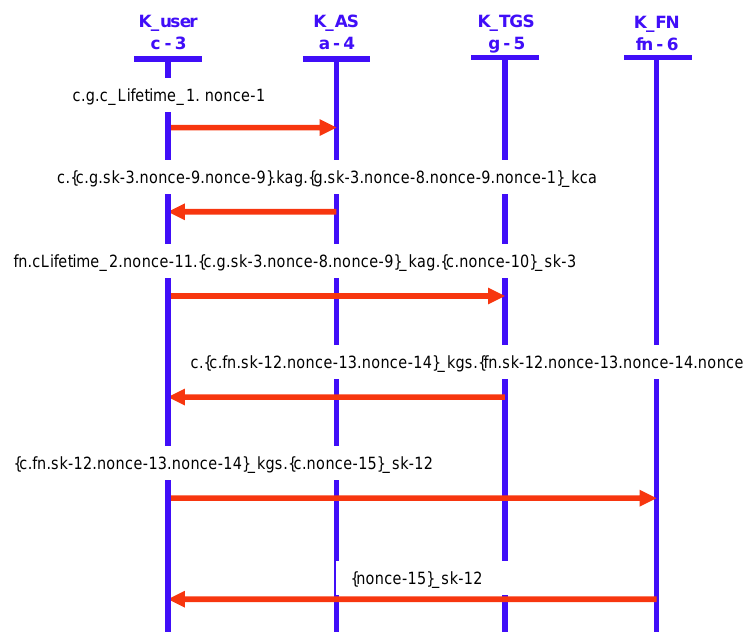
Figure 13. The simulation sequence using